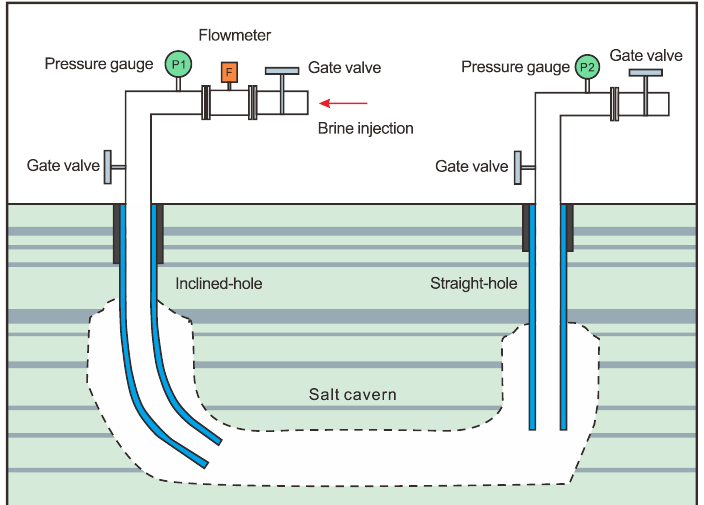
Figure 7. Schematic Diagram of Brine Injection Test.